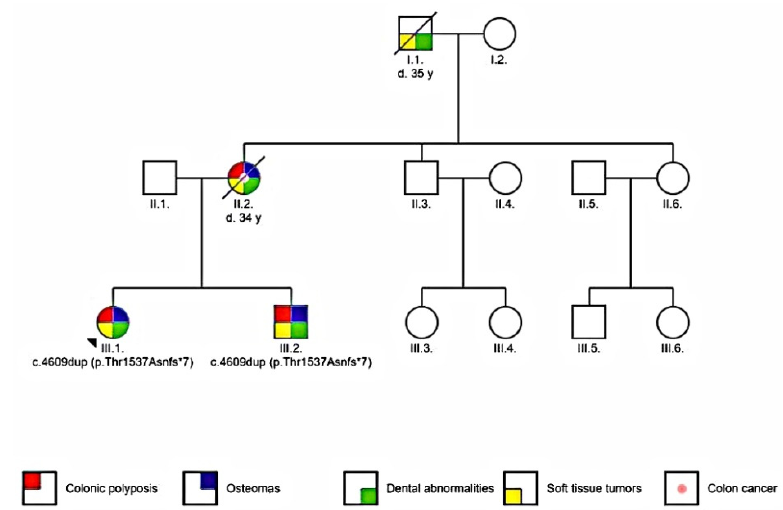
Figure 1. Pedigree of the analyzed family (arrow indicates the proband) .